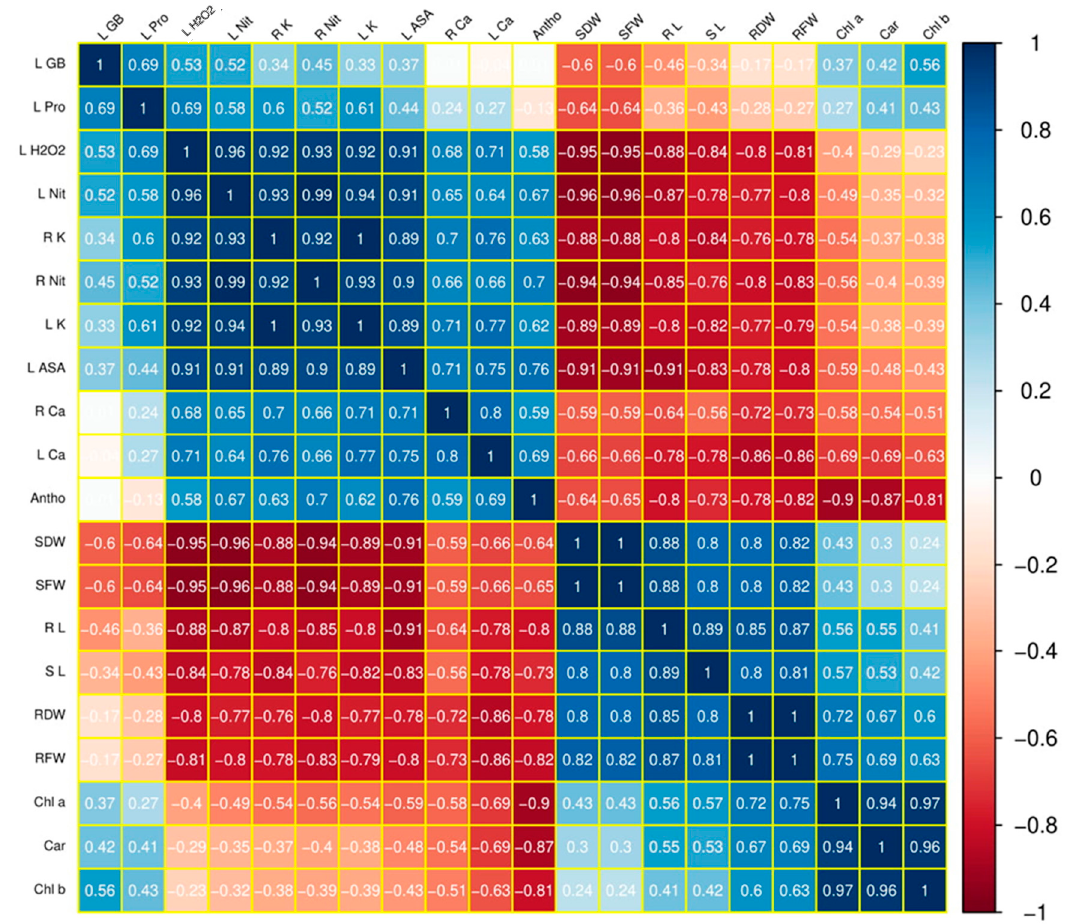
Figure 2. Correlations (r values) among the different studied parameters of maize cultivar Gohar-19 grown under different B stress levels and fertigated with and without SA. R L = root length; S L = shoot length; RFW=root fresh weight; RDW = root dry weight; SFW = shoot fresh weight; SDW = shoot dry weight; Chl a = chlorophyll a; Chl b = chlorophyll b; Car = carotenoids; Antho = anthocyanin; L ASA = leaf ascorbic acid; L H 2 O 2 = leaf hydrogen peroxide; L Pro = leaf proline; L GB = leaf glycine betaine; R K = root potassium; L K = leaf potassium; R Ca = root calcium; L Ca = leaf calcium; R Nit = root nitrate; L Nit = leaf nitrate . Table 2. Effect of SA (0, 50, 100 and 150 µM) on the plant fresh and dry weight of maize cultivar Gohar-19 under varying B toxicity levels (0, 15 and 30 mg kg − 1 ) . Treatment